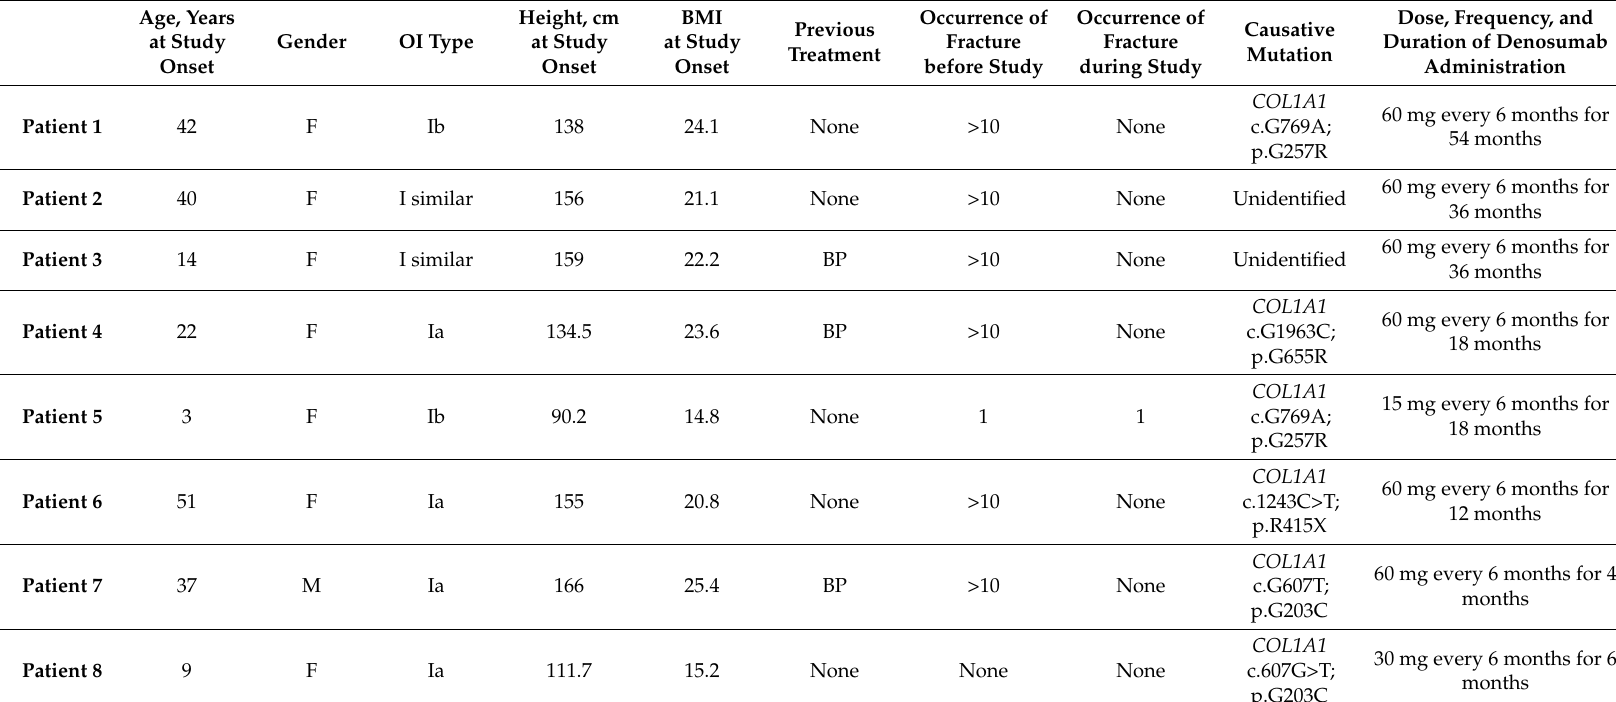
Table 1. Patient